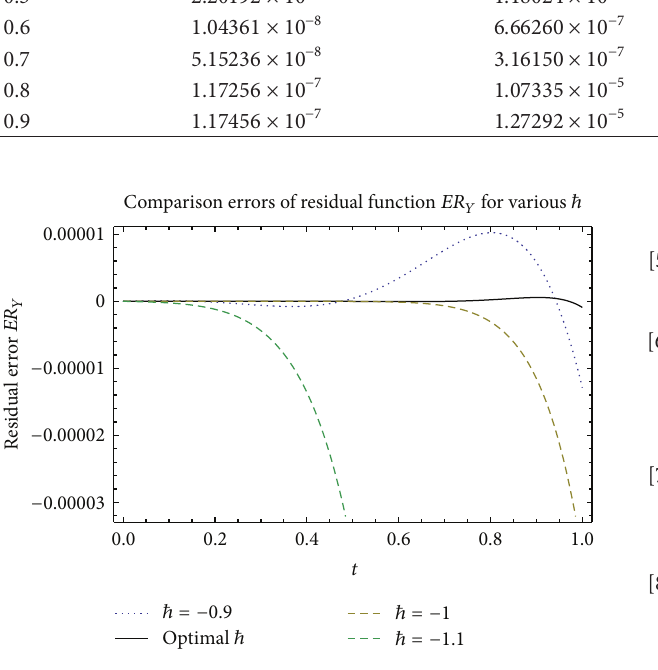
Figure 5: The errors of residual equation (42) using the sixth-order approximate solution for various ℏ and 𝑇 ∈ (0, 1)